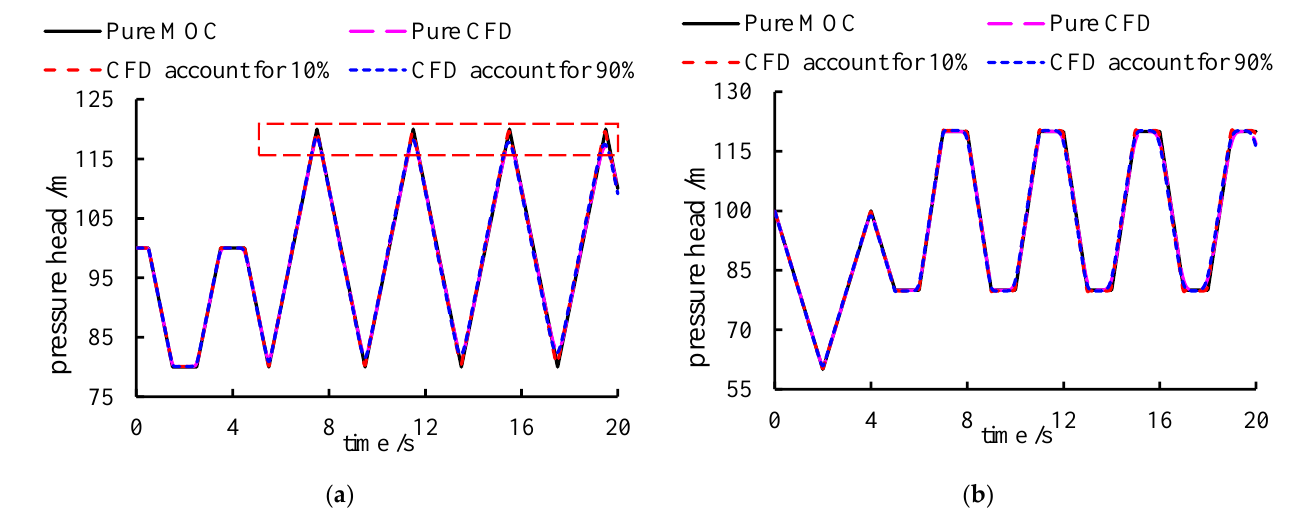
Figure 3. Pressure variation when the discharge at the valve linearly increases. ( a ) Pressure head at the center of the entire system ( b ) pressure head at the valve.